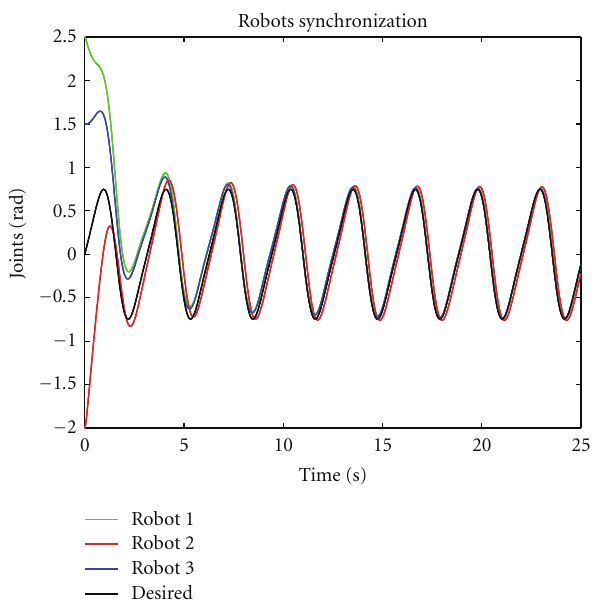
Figure 3: Synchronization of robots in the presence of uncertain